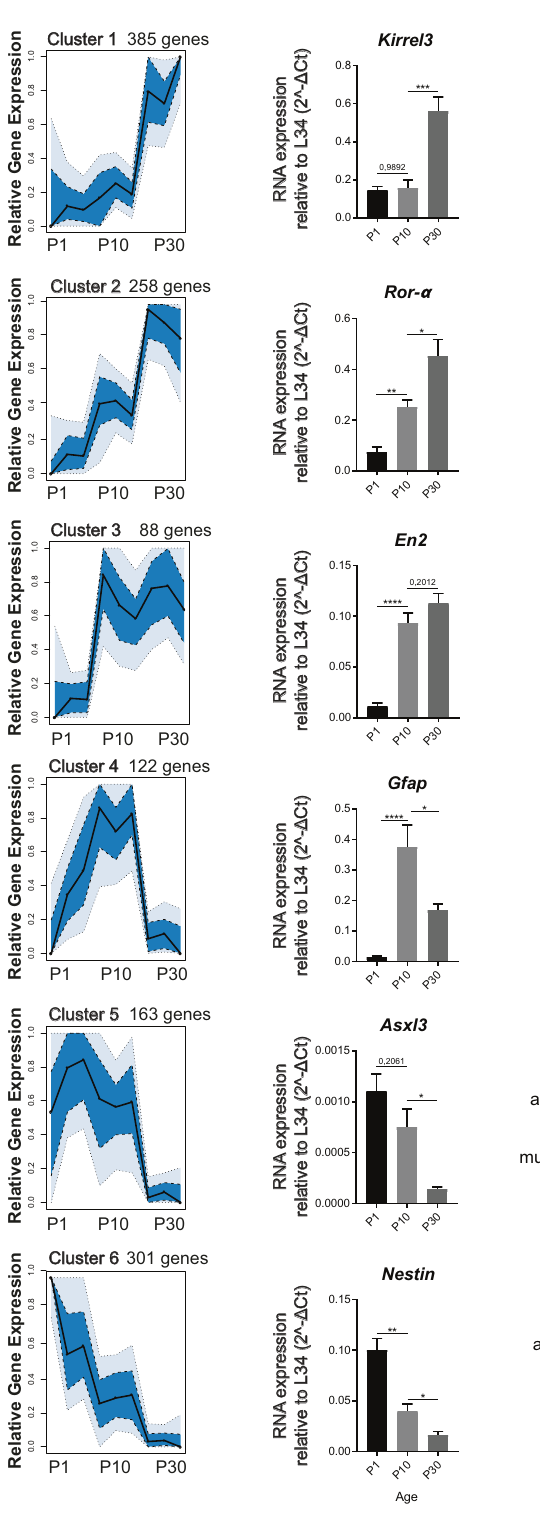
expressed in the cerebellum (Fig. 2E). Although larger size was also common to the rest of SFARI-annotated genes, those undergoing dynamic expression changes were signi fi cantly larger (Fig. 2E). Moreover, we found that SFARI-annotated genes are characterized